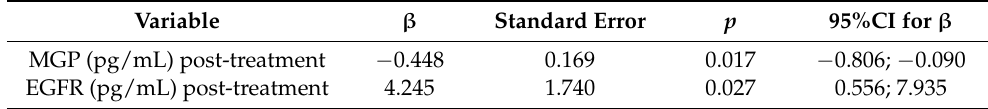
Table 6. Post-treatment values for Gas 6 after multivariate linear